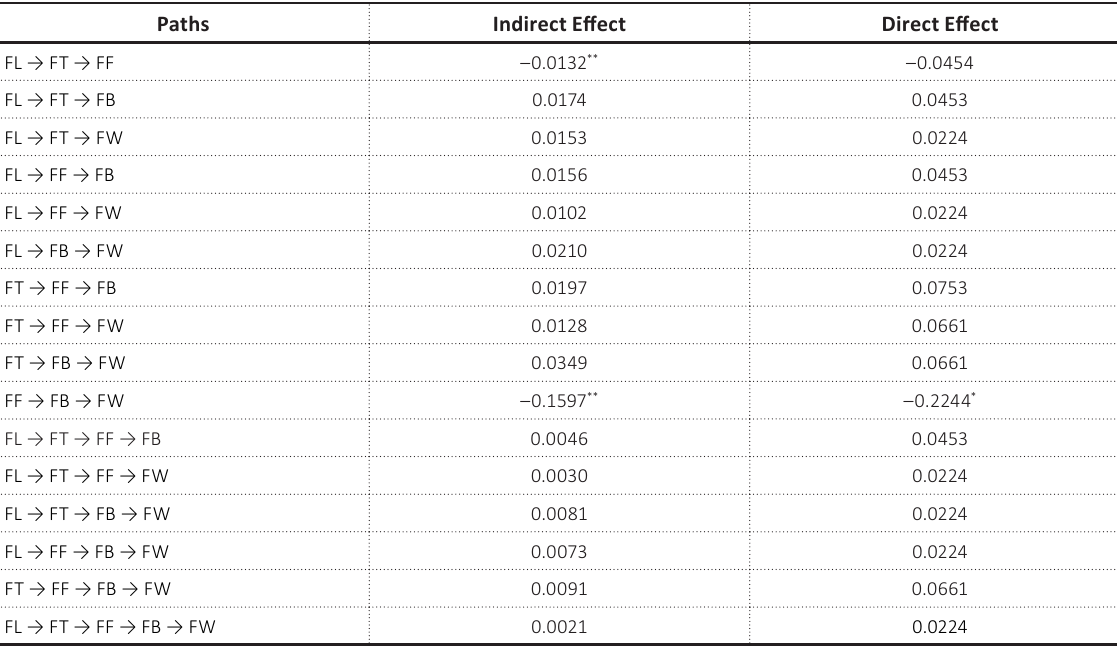
Table 8. Specific indirect effects for mediation analysis Paths